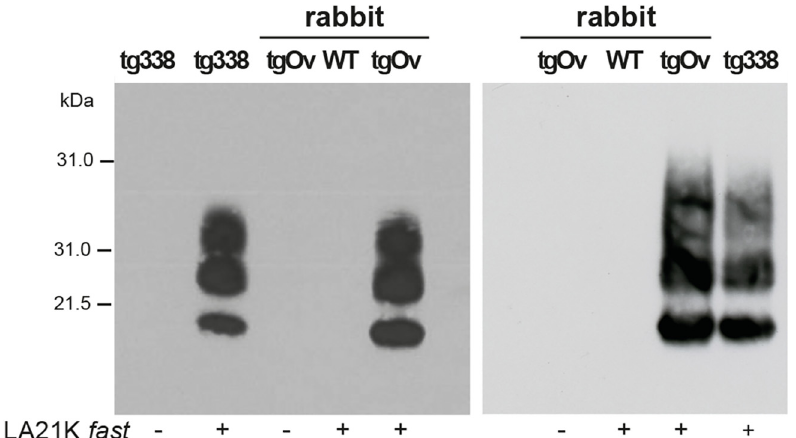
Fig 6. Infection of Rov cells with TgOv- and tg338-passaged LA21K fast prions. Western blot analyses for the presence of PrP res in lysates from Rov cells exposed to brain homogenates from WT, tgOv rabbits and tg338 mice that were mock infected or challenged with LA21K fast prions. Analysis was performed two (left panel) and four passages (right panel) after initial exposure of the cells. The loaded samples were normalized relative to total protein